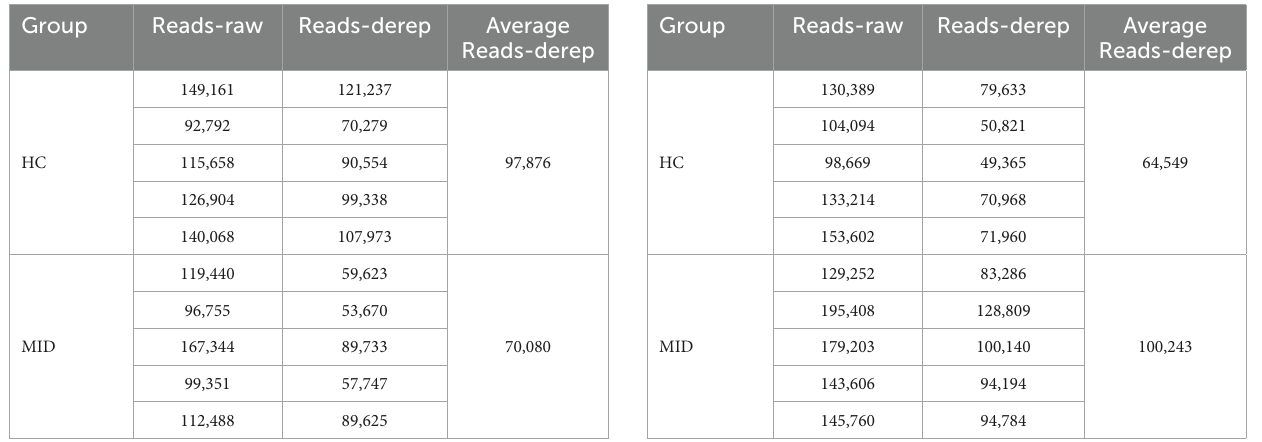
TABLE 1 Basic data for sequencing gut microbiome samples. TABLE 2 Basic data for sequencing oral microbiome